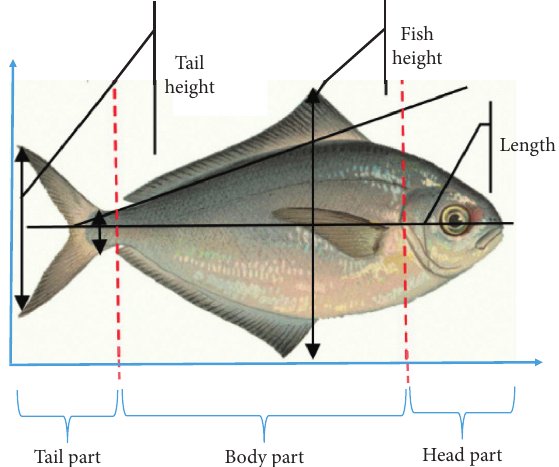
Figure 8: Potential feature that the system can extract within the NN